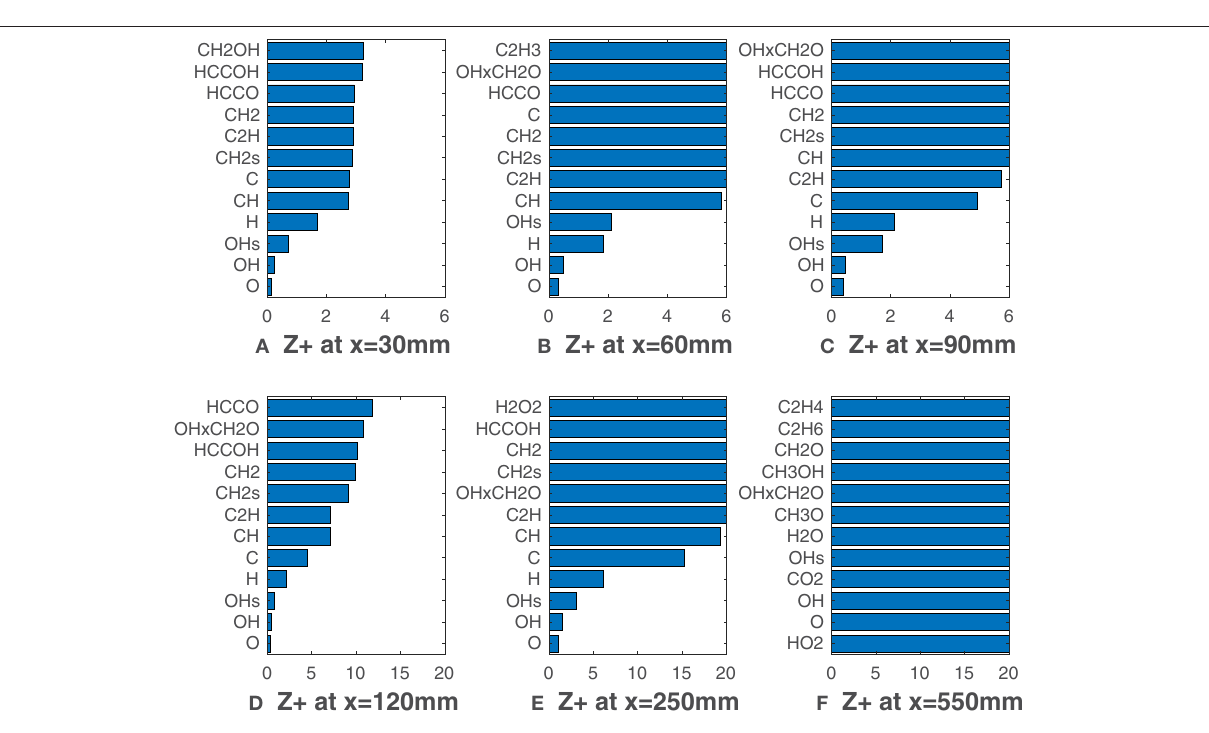
FIGURE 5 | HM3 case: best correlated species at various axial locations. Lower Z + s ( X α ) values mean better correlation. sampled segment at x = 550 mm ( Figure 4F ). Moreover, at this axial location, the reactions H + HO 2 < = > 2 OH and H + HO 2 < = > O + H 2 O do not appear, even though their reaction rates were found to be good HRR indicators by Nikolaou and Swaminathan (2014) for lean to near-stoichiometric methane-air mixtures and especially at low value of